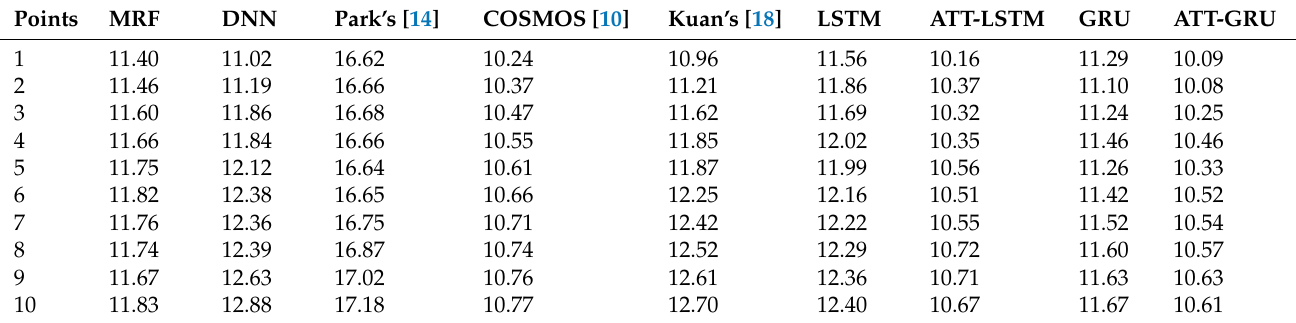
Table A6. Coefficient of variation of the root mean squared error comparison for Building